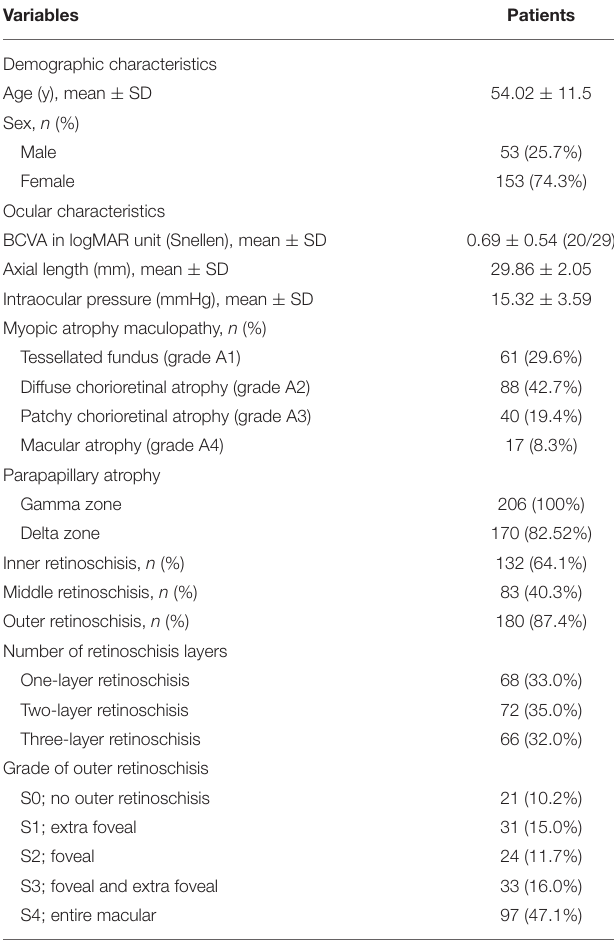
TABLE 1 | Demographic and ocular characteristics of patients with myopic tractional maculopathy.